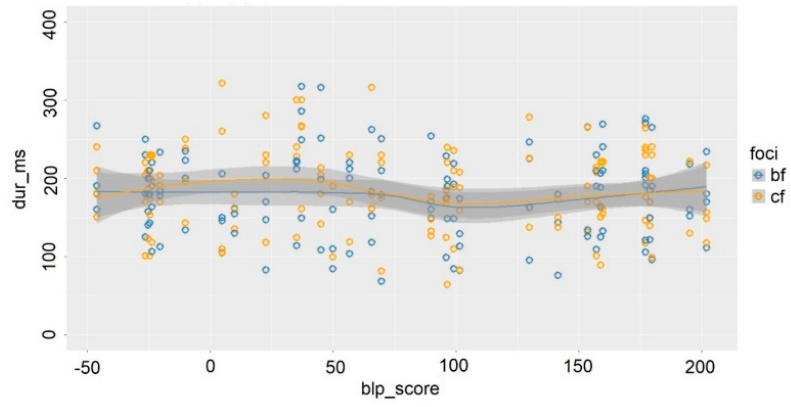
Figure 7. Duration (in ms) of the stressed syllables of the target words in object position in broad focus (“bf”) and contrastive focus (“cf”) conditions in relation to Bilingual Language Profile (BLP) scores. Each vertical line corresponds to a participant’s BLP score.